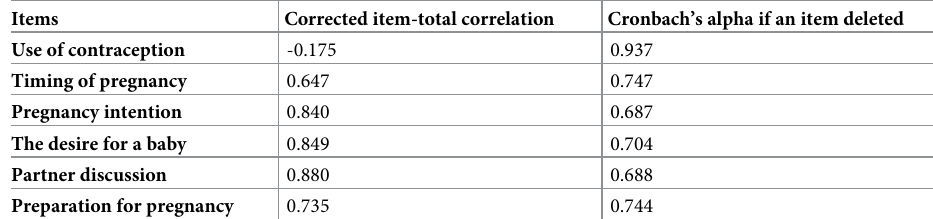
Table 6. Corrected item-total correlation with Cronbach’s alpha.